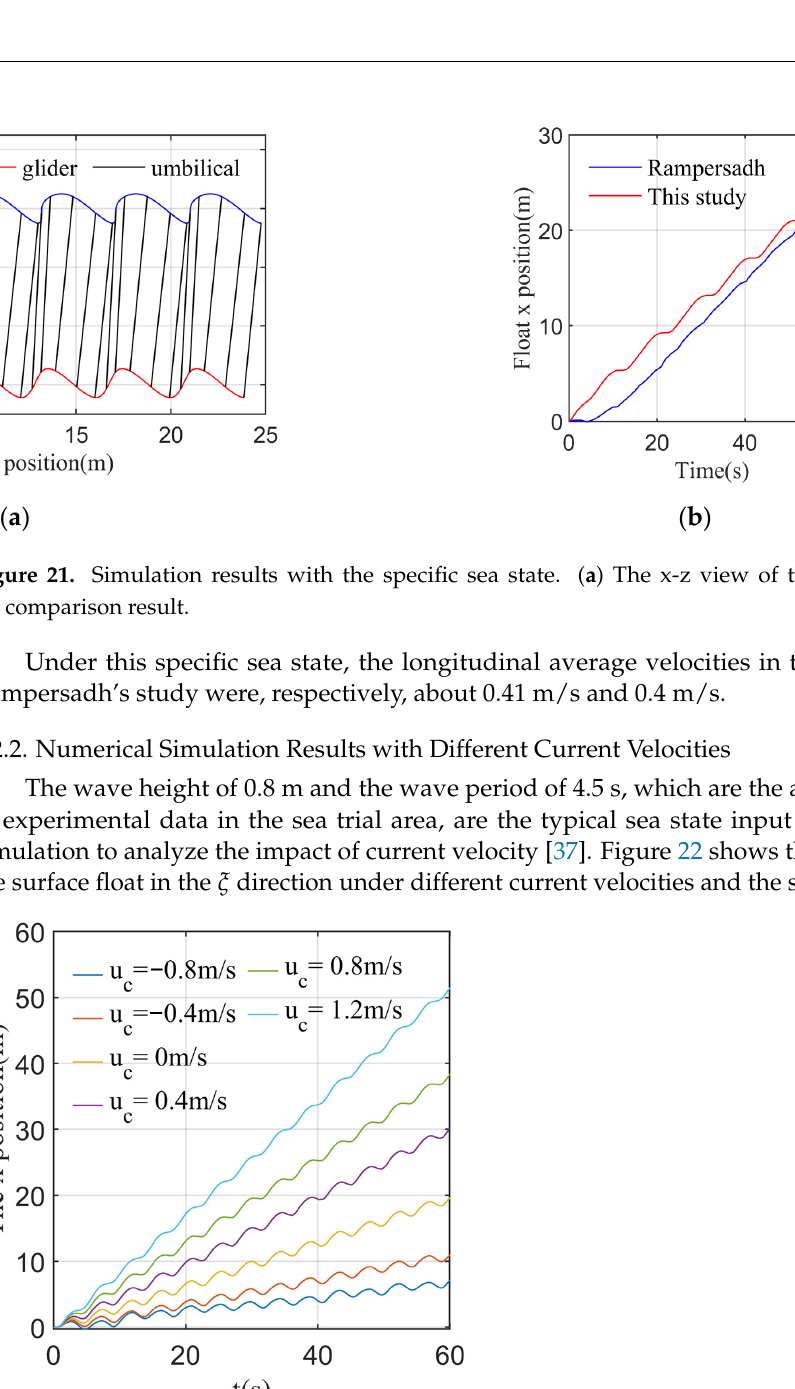
( b ) Figure 20. Experimental data in the sea trial: ( a ) varying significant wave heights and wave periods; ( b ) the pitching angle of the submerged glider. 4.2. Numerical Simulation 4.2.1. Numerical Simulation with the Specific Sea State Rampersadh calculated resultant propulsion effect on the float under wave height of 1m and wave period of 10 s [10]. In order to compare with Rampersadh’s calculation results, the dynamic characteristics of the wave glider under the same sea state were